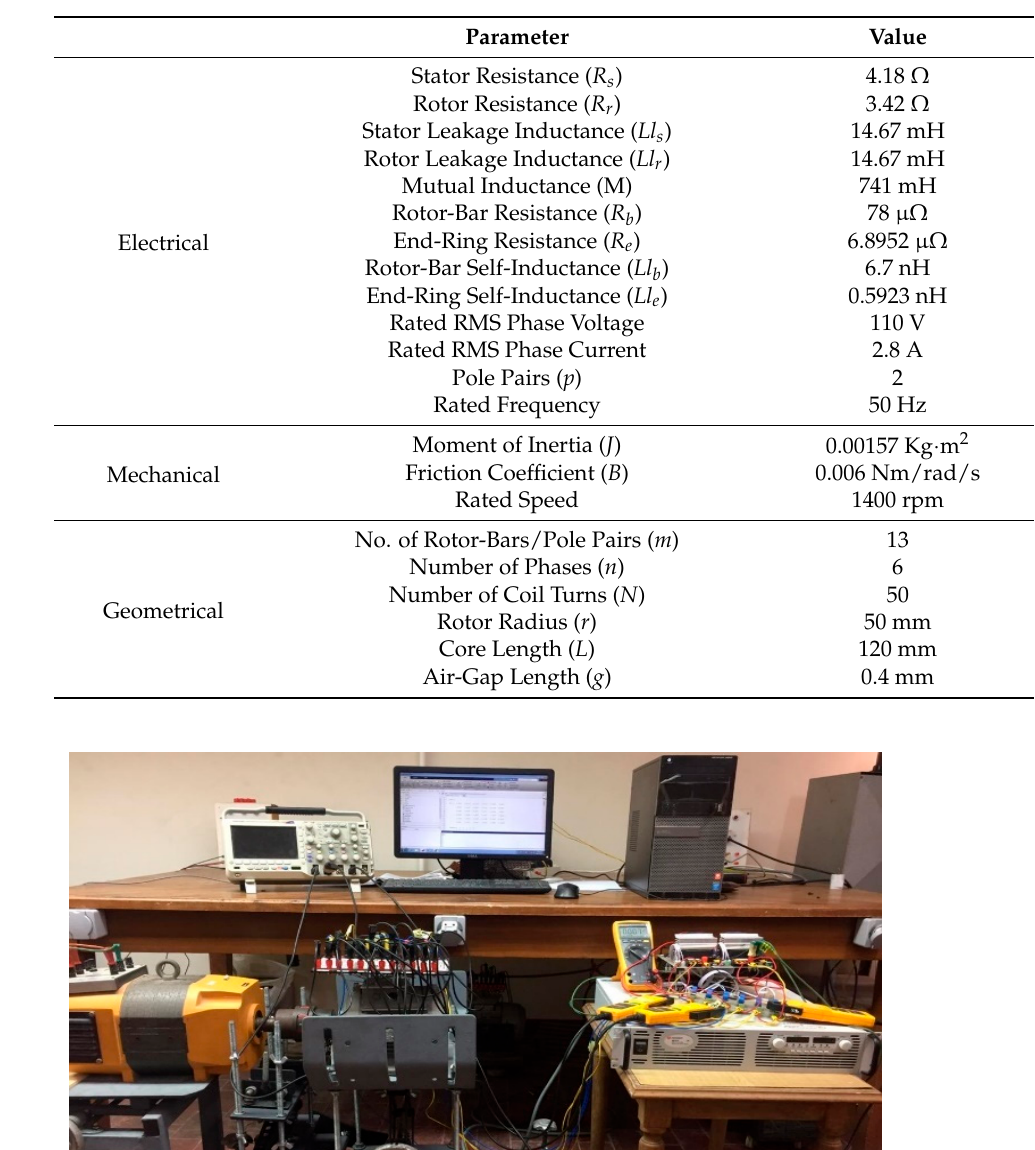
Table 1. Symmetrical six-phase induction motor parameters.